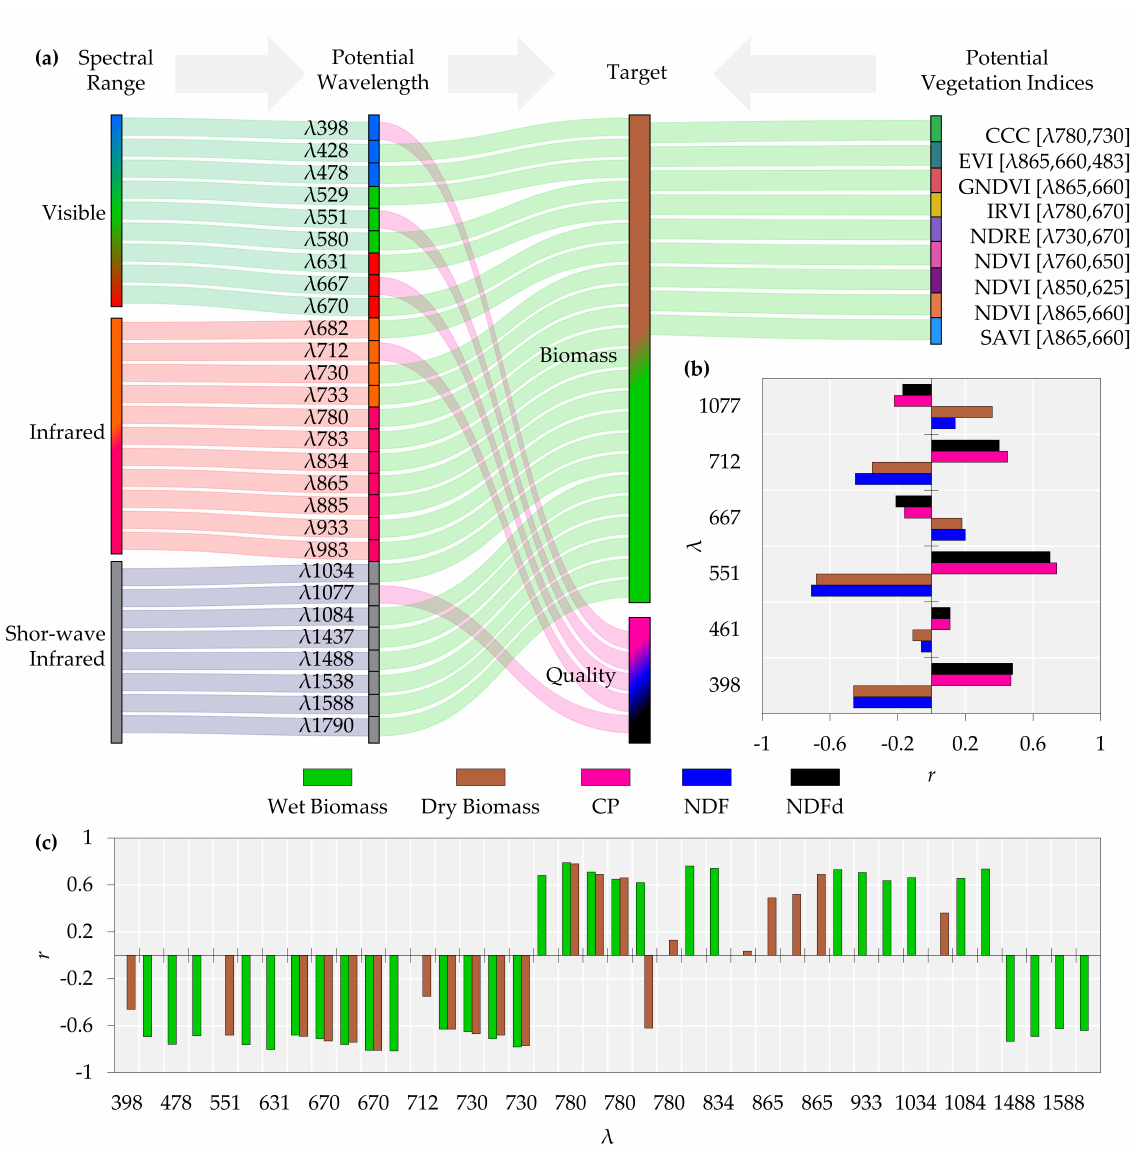
Figure 2. ( a ) Sankey diagram illustrates the potential wavelengths and vegetation indices for es- tablishing relationships with biomass and quality in alfalfa. ( b ) Only in the study developed by Noland et al. [26] was it possible to obtain information about the relationship between biomass and quality for the same wavelength, the bar graph shows that CP and NDFd have a relation among themselves and, as well as dry biomass and NDF, both sets with an inverse relationship. ( c ) The remaining studies focused their evaluations only on biomass, where it is possible to observe in the bar graph that dry biomass is related to wet